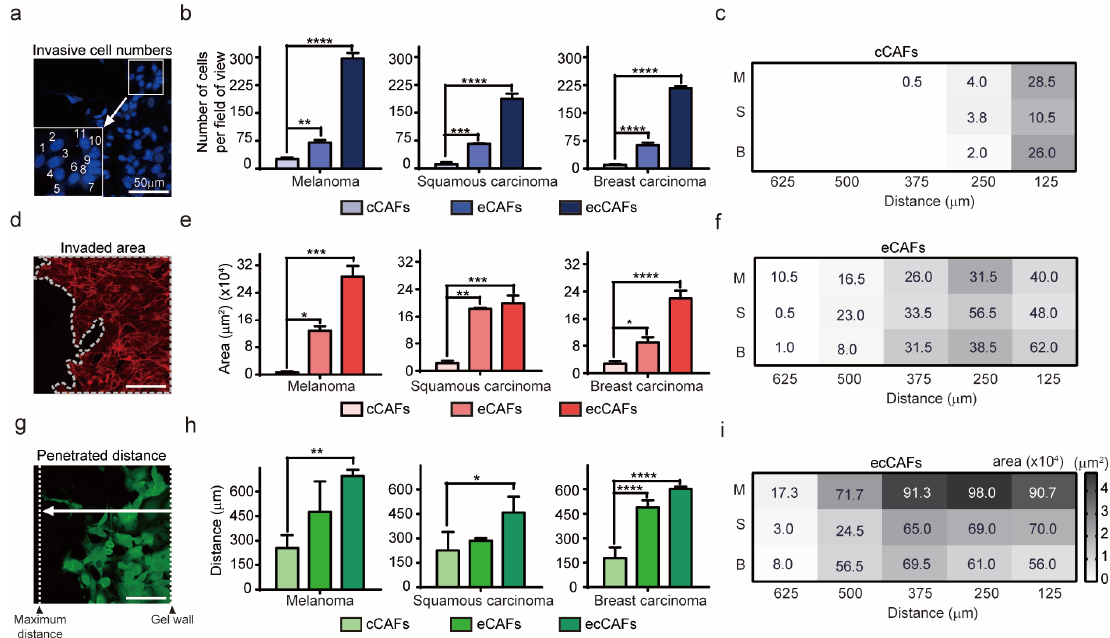
Figure 1. Physiological evidence of CAF-induced invasion. ( a , d , g ) Schematic diagram showing the measurement analysis process of cancer cell invasion. Scale bar: 50 µ m. ( b , e , h ) Comparison of the number, distance, area and invasiveness of the three different cancer cell types. ( c , f , i ) Analysis of invasiveness based on area of invasive cells in relation to distance travelled into the ECM matrix. Larger areas are represented by darker color. The numbers indicate the degree of invasiveness of cells (M: Melanoma; S: Squamous carcinoma; B: Breast carcinoma). Data are presented as means ± SEM (* p -value < 0.05, ** p -value < 0.01, *** p -value < 0.001, **** p -value < 0.0001).